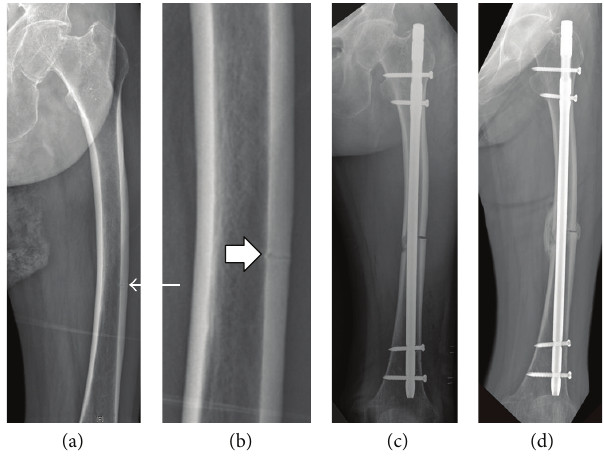
F 2: (a) A 74-year-old woman suffered thigh pain and her AP radiograph showed exaggerated femoral bowing with a transverse radiolucent line (arrow) in the lateral cortex of the distal 1/3 of the le femur. (b) A magni�ed view (box arrow) of the lesion revealed an incomplete, prefracture lesion of an atypical femoral fracture. (c) Aer preventive IM nailing, a complete fracture occurred. (d) e union was achieved with callus bridging at 18 weeks